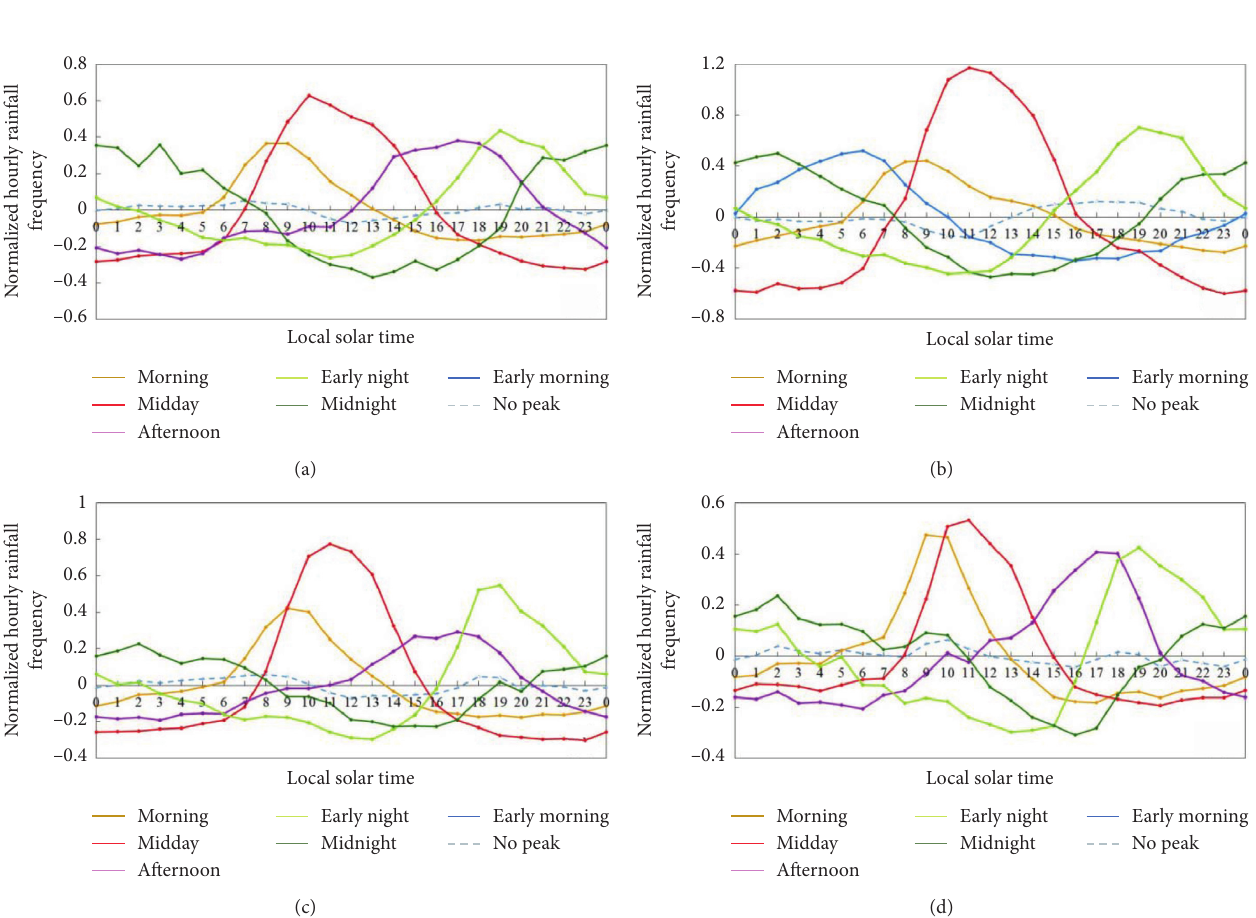
Figure 3: Curve of normalized hourly precipitation frequency corresponding to each type of diurnal variation of precipitation in Figure 2: (a) for spring, (b) for summer, (c) for autumn, and (d) for winter.